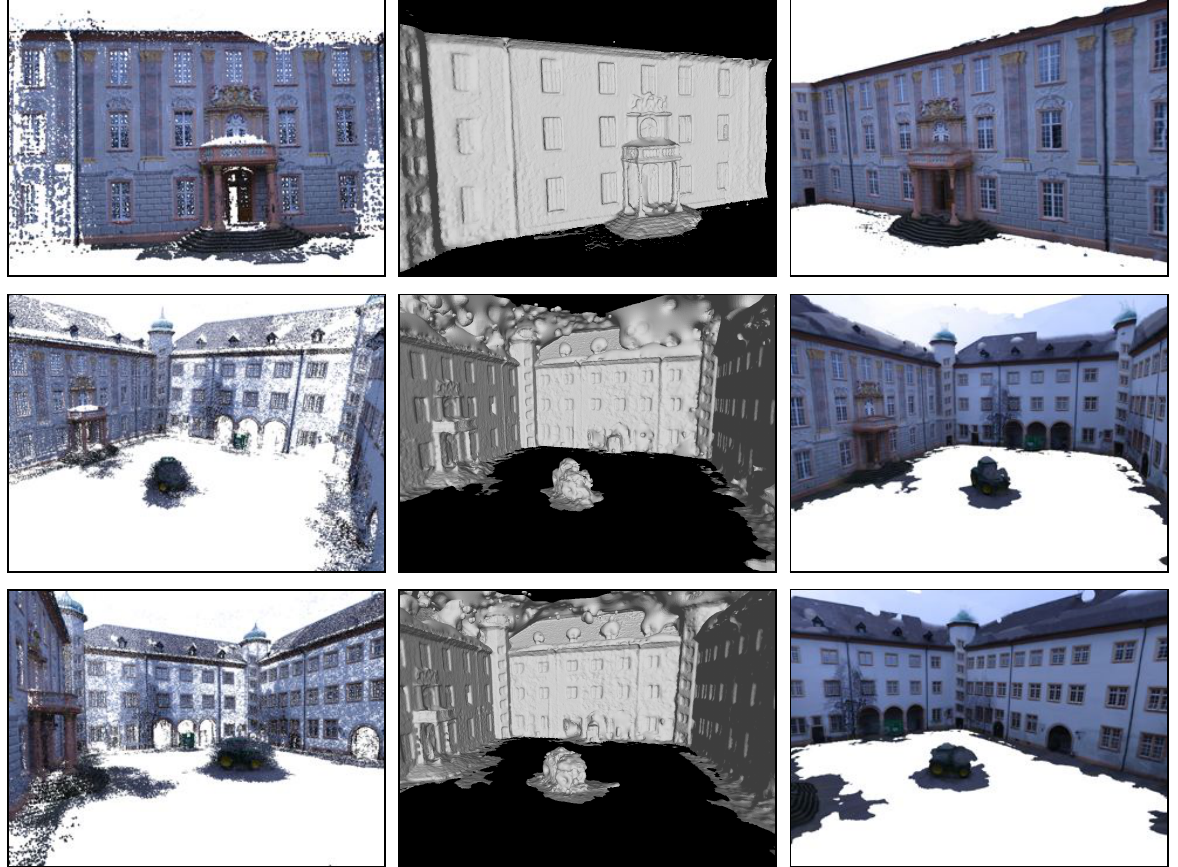
Figure 7: Multiview Stereo Results. From left to right, Stereo Points, Shaded Surfaces and Textured Surfaces are reported. The datasets are, from top to bottom, Entry-P10, Castle-P19, and